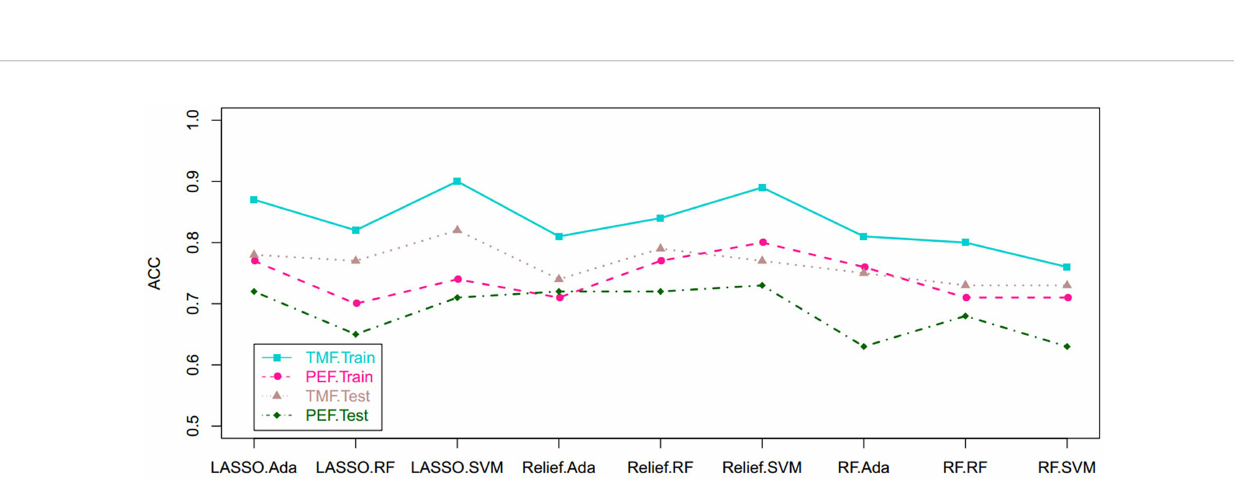
FIGURE 3 | Scatterplots depict the AUC of the cross-combination methods based on the features derived from the tumor and peritumoral edema, respectively. AUC, area under the curve.